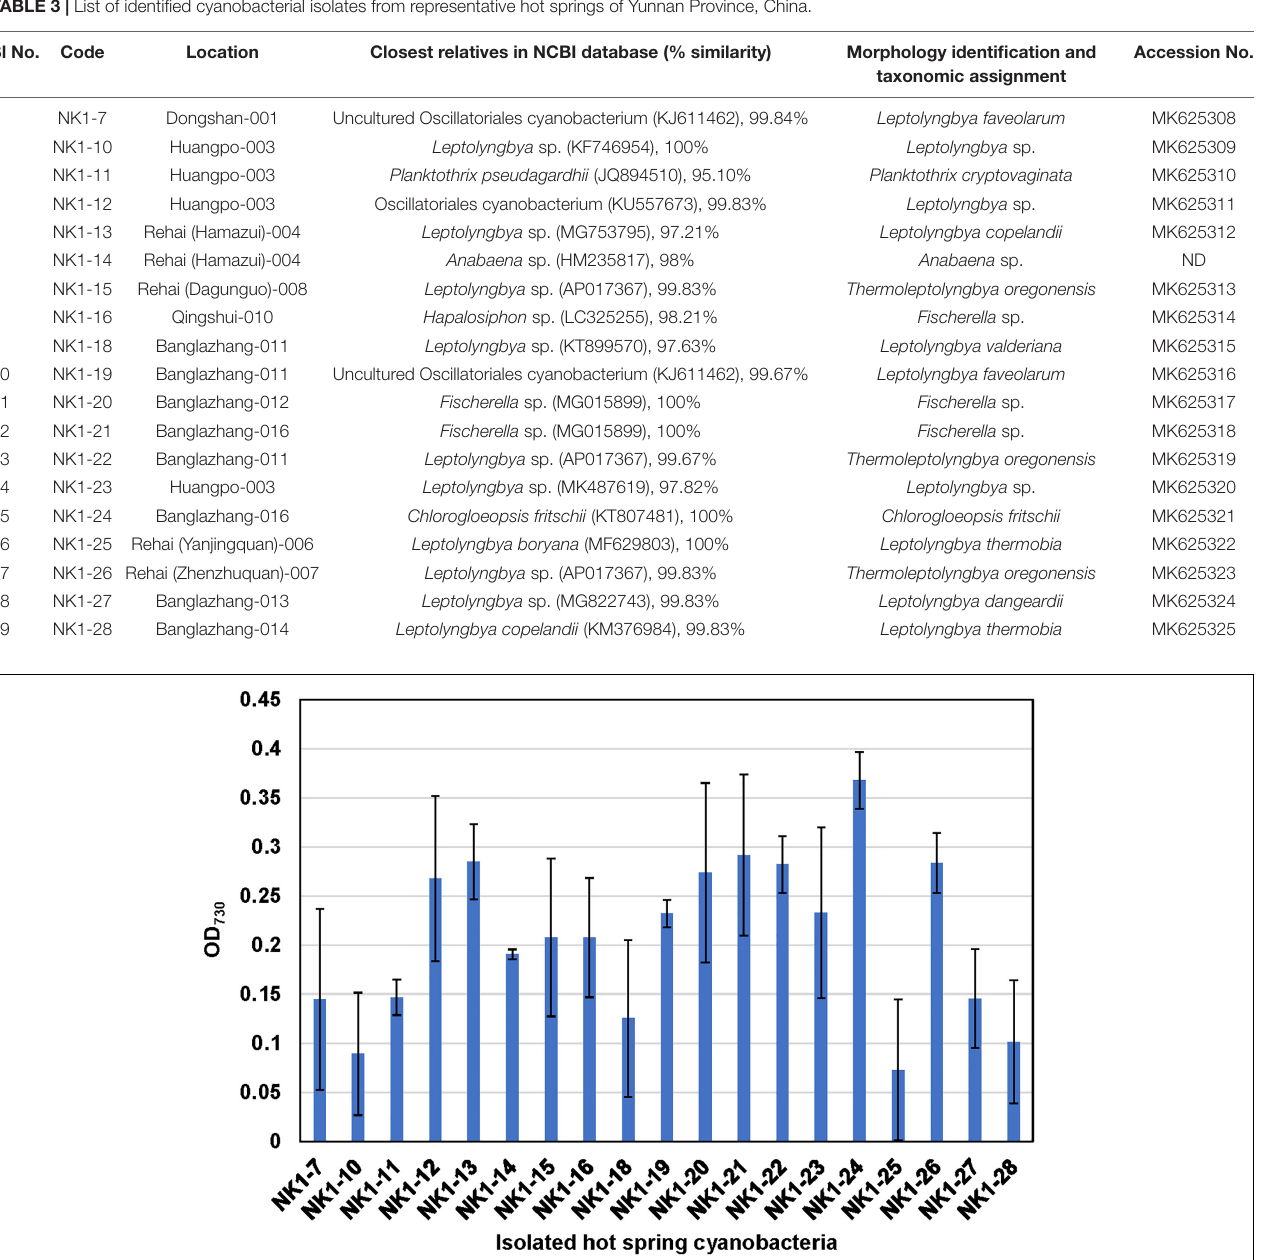
FIGURE 7 | Verification of the thermotolerant feature of the hot spring cyanobacterial isolates. Note that the isolated cyanobacterial species was grown statically in 10-ml test tubes at 50 ◦ C under 30 µ mol photon m − 2 s − 1 light intensity for 10 days.